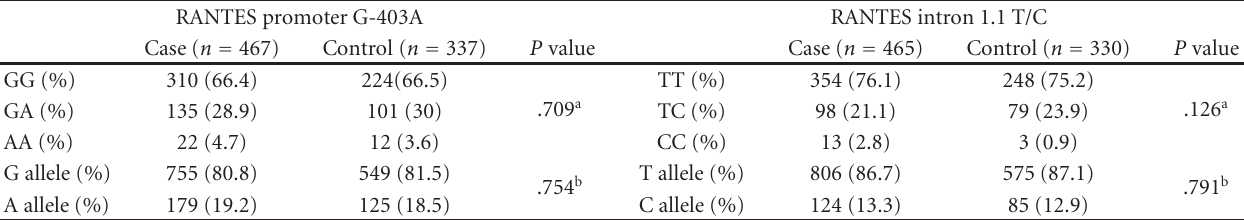
Table 2: RANTES promoter and intron polymorphisms: genotype and allele distribution in Slavonic patients with MI and control